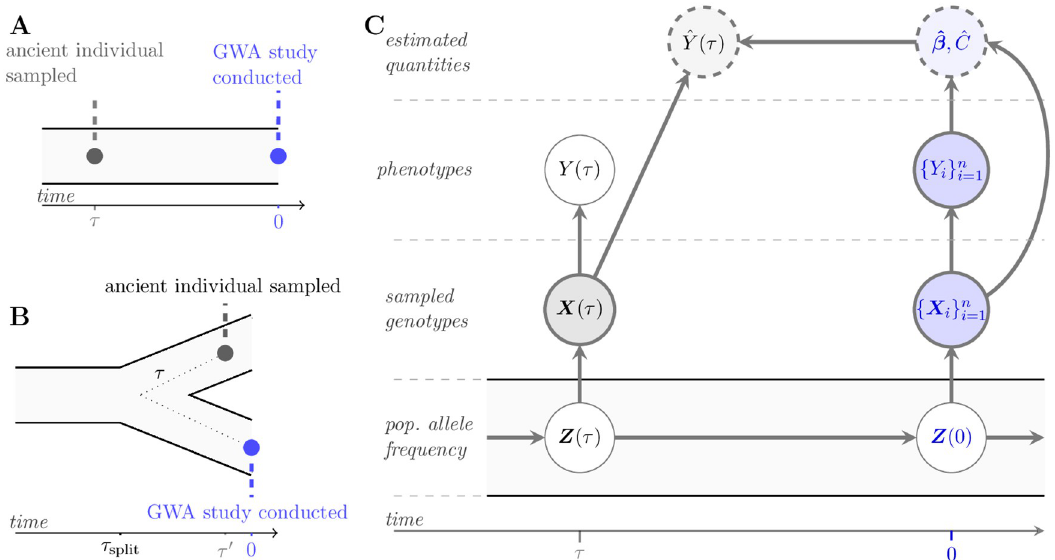
Fig 1. A population genetic model for an ancient polygenic score. Figures (A) and (B) portray the two demographic scenarios encompassed by our modeling framework. In (A), the ancient individual is sampled at an earlier time τ from the same population in which the GWA study is conducted. In (B), the ancient individual is sampled at an arbitrary time τ 0 from a population that split from the population in which the GWA study was conducted at some time τ split in the past. The dotted line schematically relates τ 0 to the ancient sampling time τ of (A), i.e., τ = 2 τ split − τ 0 . In (C), a graphical model relates the random variables explicit and implicit in the polygenic score ^ Y ð t Þ and phenotype Y ( τ ) of an ancient individual sampled τ generations in the past, as in (A). Darkly shaded and thickly bordered nodes are observed quantities. Unshaded and thinly bordered nodes are unobserved. Lightly shaded nodes bordered by dashed lines denote estimated quantities. Edges denote direct dependencies between connected nodes. For example, conditional on the ancient genotype X ( τ ), the polygenic score ^ Y ð t Þ is independent of the population allele frequencies Z ( τ ). Quantities in blue are associated with the present day only, and include the population allele frequencies Z (0); the genotypes of the n individuals in the GWA study, f X g n and their phenotypes, f Y g n ; and, the effects and intercept term estimated in the GWA i i i ¼ 1 i ¼ 1 study, ^ β and ^ C ,